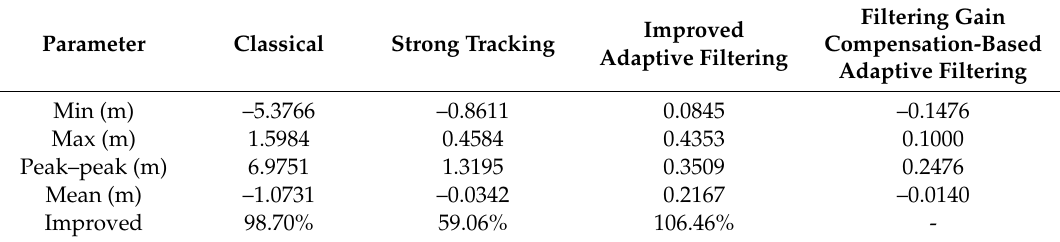
Figure 5. The positioning error of the different methods. Table 1. The statistical positioning error parameter of the different methods.